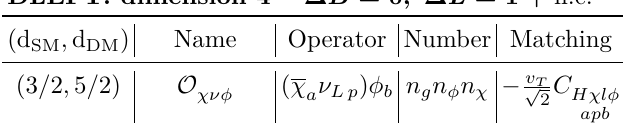
Table 25 . Dimension-four ∆ B = 0 , ∆ L = 1 operator in DLEFT. The first column gives the dimensions of the SM and DM part of the operator, the fourth column is the number of operators, and the fifth column is the additional matching contribution at the EW scale.